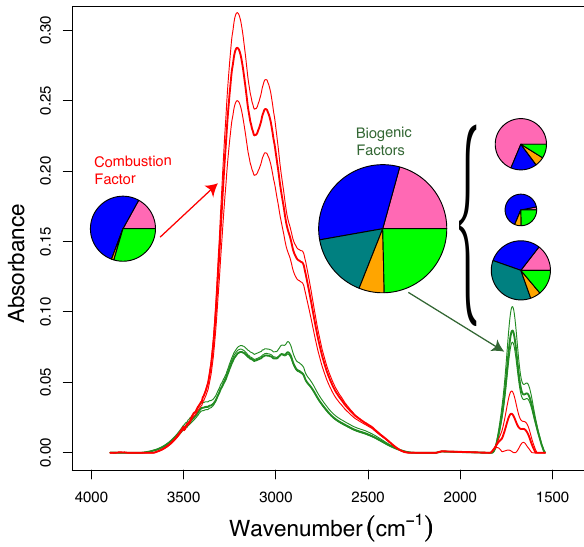
Fig. 4. FTIR spectra (for FPEAK of 0, 0.2 (bold), and 0.4) and OFG composition of summed biogenic and combustion PMF source fac- tors. The pie charts show the average OFG composition for each factor, with the colors as given in Fig. 2 (organic hydroxyl (pink), alkane (blue), ketone (teal), amine (orange), acid (green)). The summed biogenic factor is made up of the three parts shown, where the composition pie for each part is scaled to its contribution to OM.